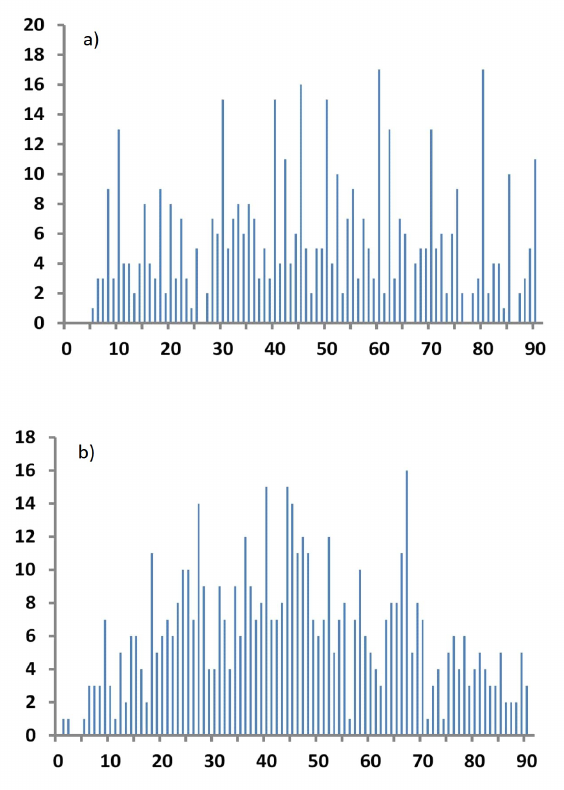
Figure 10. Frequency distributions of beam declinations to sighting from a) surveys in 2007 and 2009 around Iceland using Suunto inclinometers, and b) surveys in 2015 and 2016 around Iceland using Geometers.